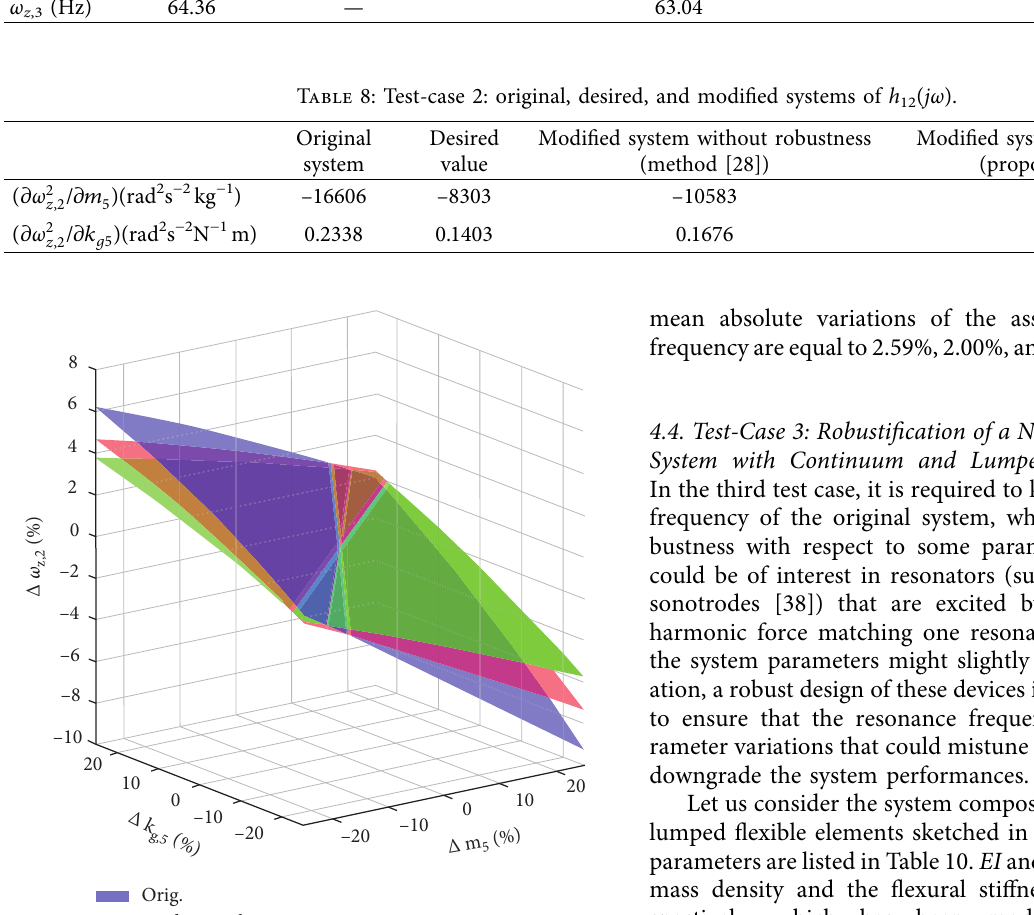
Table 7: Test-case 2: original, desired, and modified antiresonance frequencies of h Original system